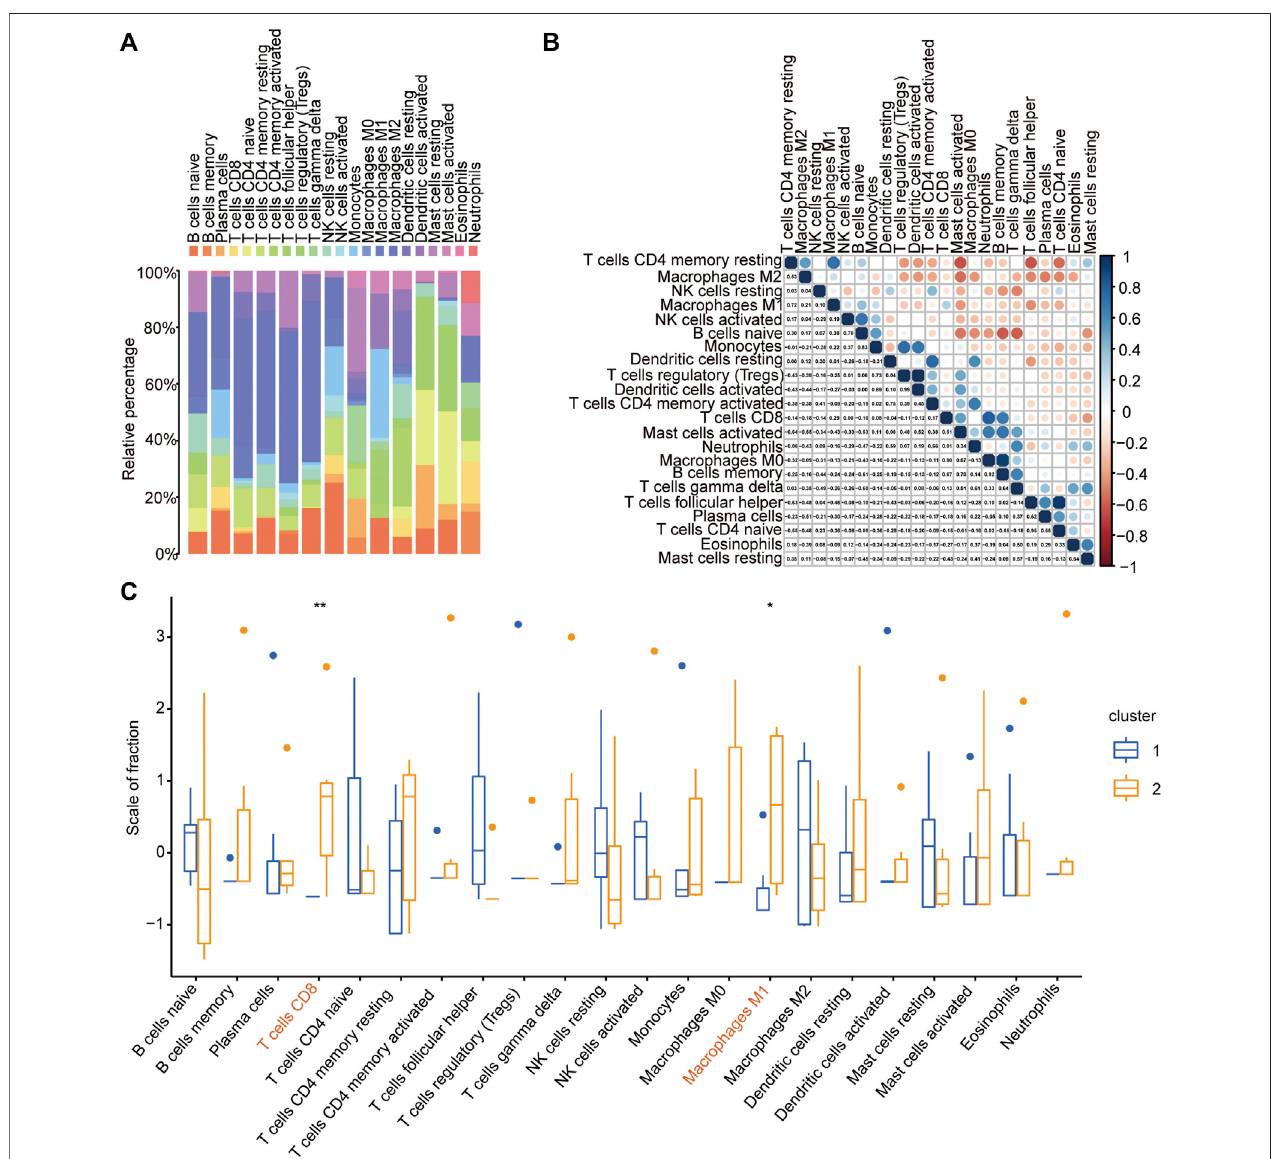
FIGURE 8 | Immune cell in fi ltration analysis of IDEG subtypes. (A) The landscape of the 22 types of immune cells in fi ltration in ATAAD samples based on CIBERSORT algorithm. (B) The correlation of the 22 types of immune cells. (C) The comparison of the 22 immune cells in fi ltration proportion between the two immune- related clusters in